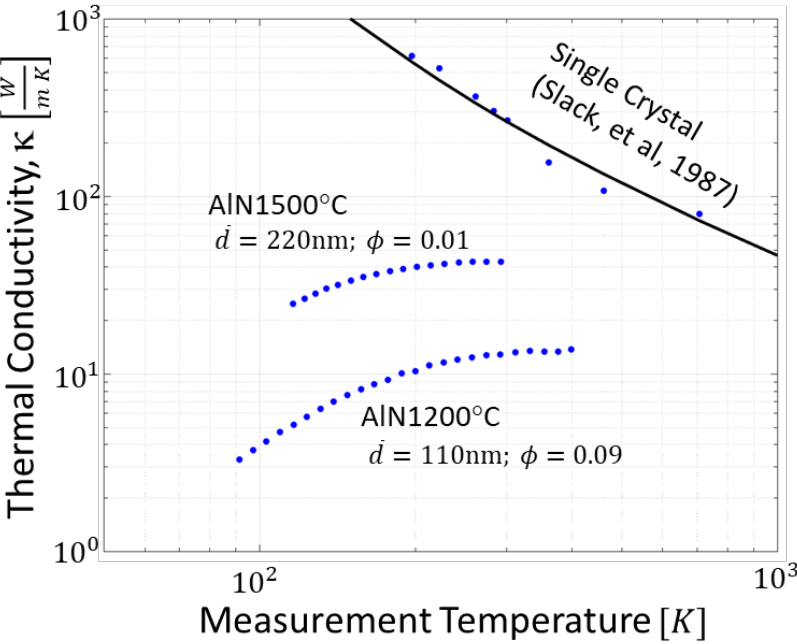
Figure 8. The temperature dependence of the thermal conductivity of polycrystalline AlN.